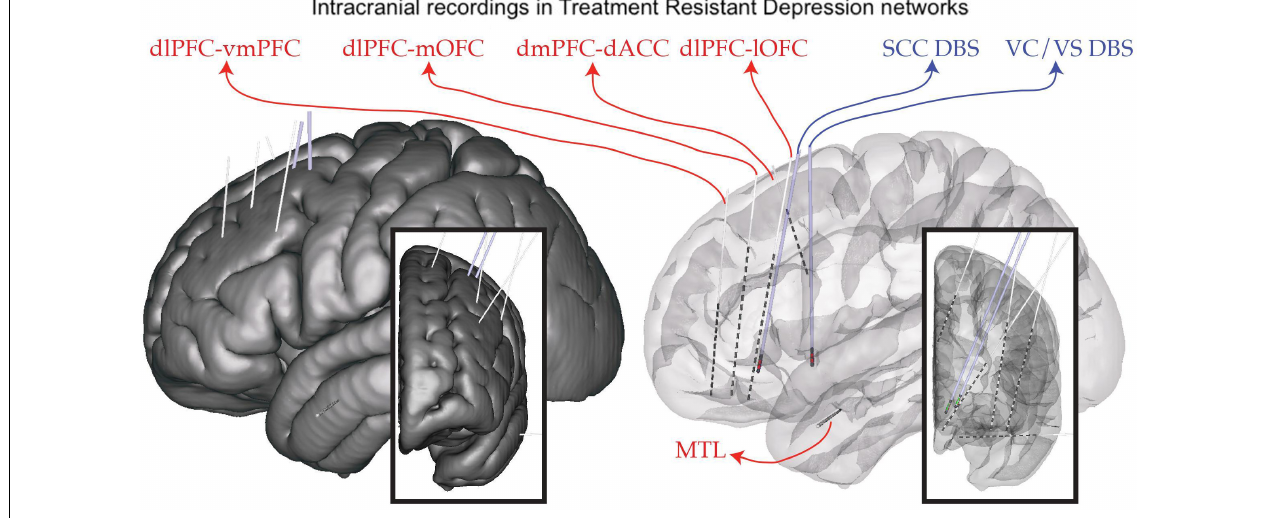
FIGURE 1 | Implant plan. StereoEEG electrodes (red) are placed in a variety of brain regions thought to be part of the depression network (dorsolateral prefrontal cortex, dlPFC; ventrolateral PFC, vlPFC; dorsomedial PFC, dmPFC; medial and lateral orbitofrontal cortex, mOFC, lOFC; dorsal anterior cingulate cortex, dACC; medial temporal lobe, MTL). DBS leads (blue) are placed in the subcallosal cingulate (SCC) and ventral capsule/ventral striatum (VC/VS). Placement is individualized using tractography derived from diffusion